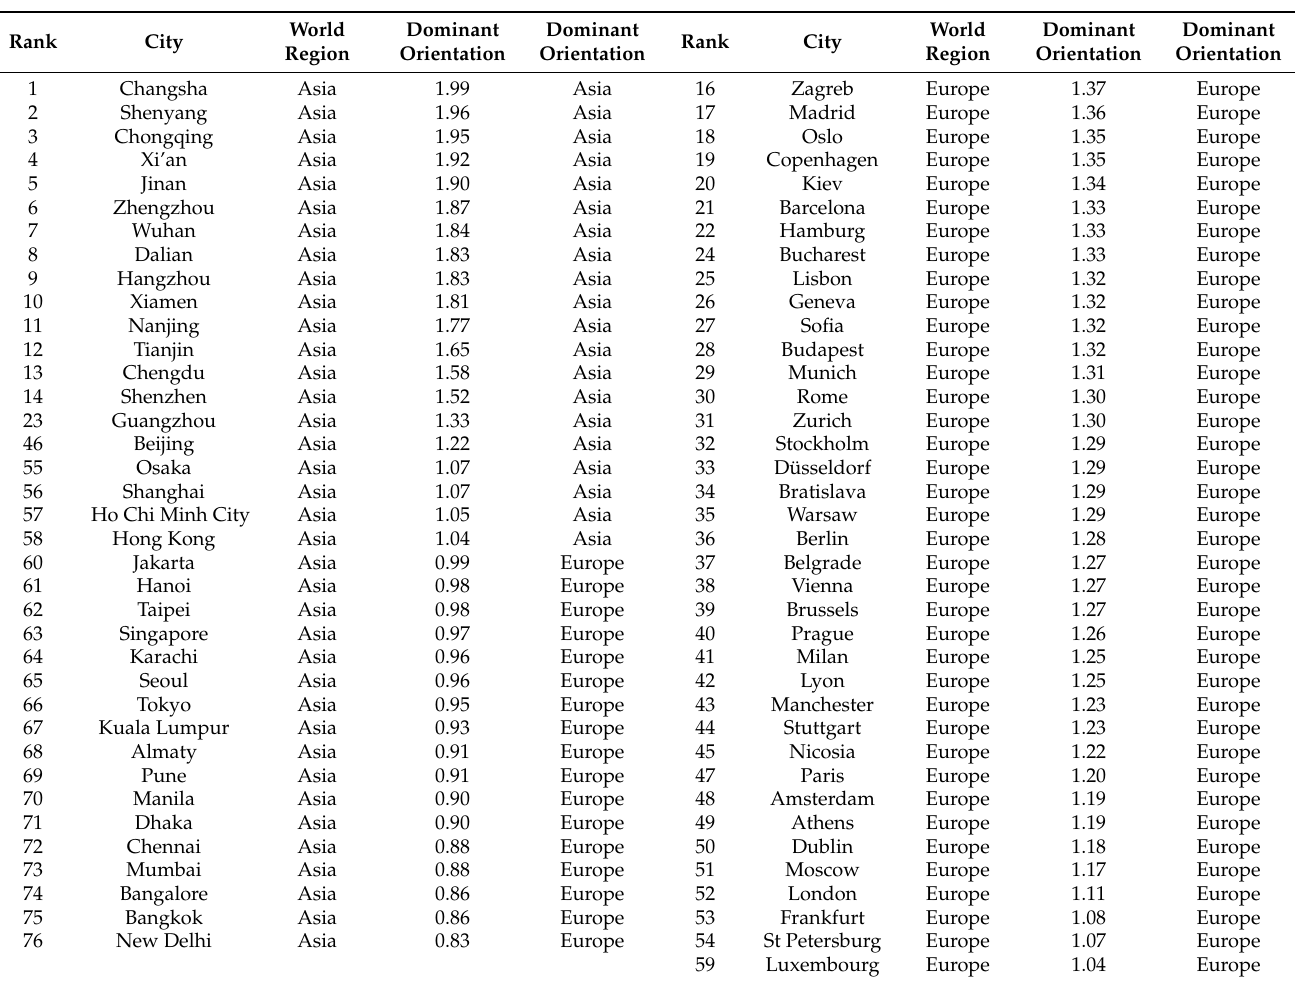
Table 5. Cities’ ranks based on their level of